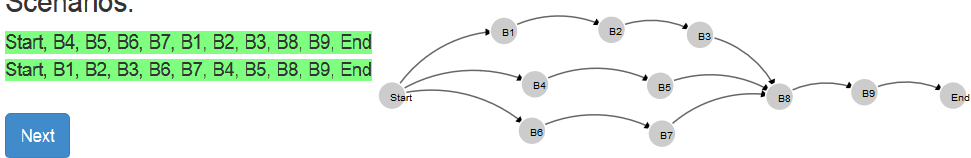
Figure 8. Candidate model that corresponds to the performed scenarios.